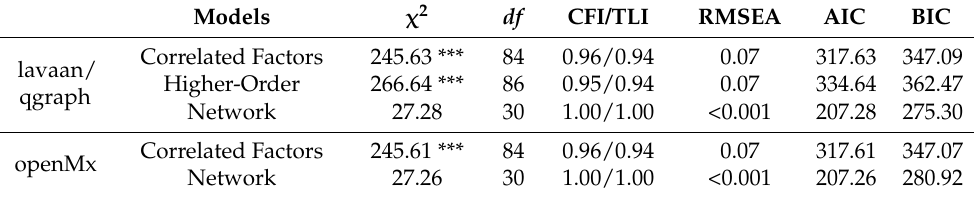
Table 6. Model fit for latent variable and network models of WAIS-IV correlations (older group).